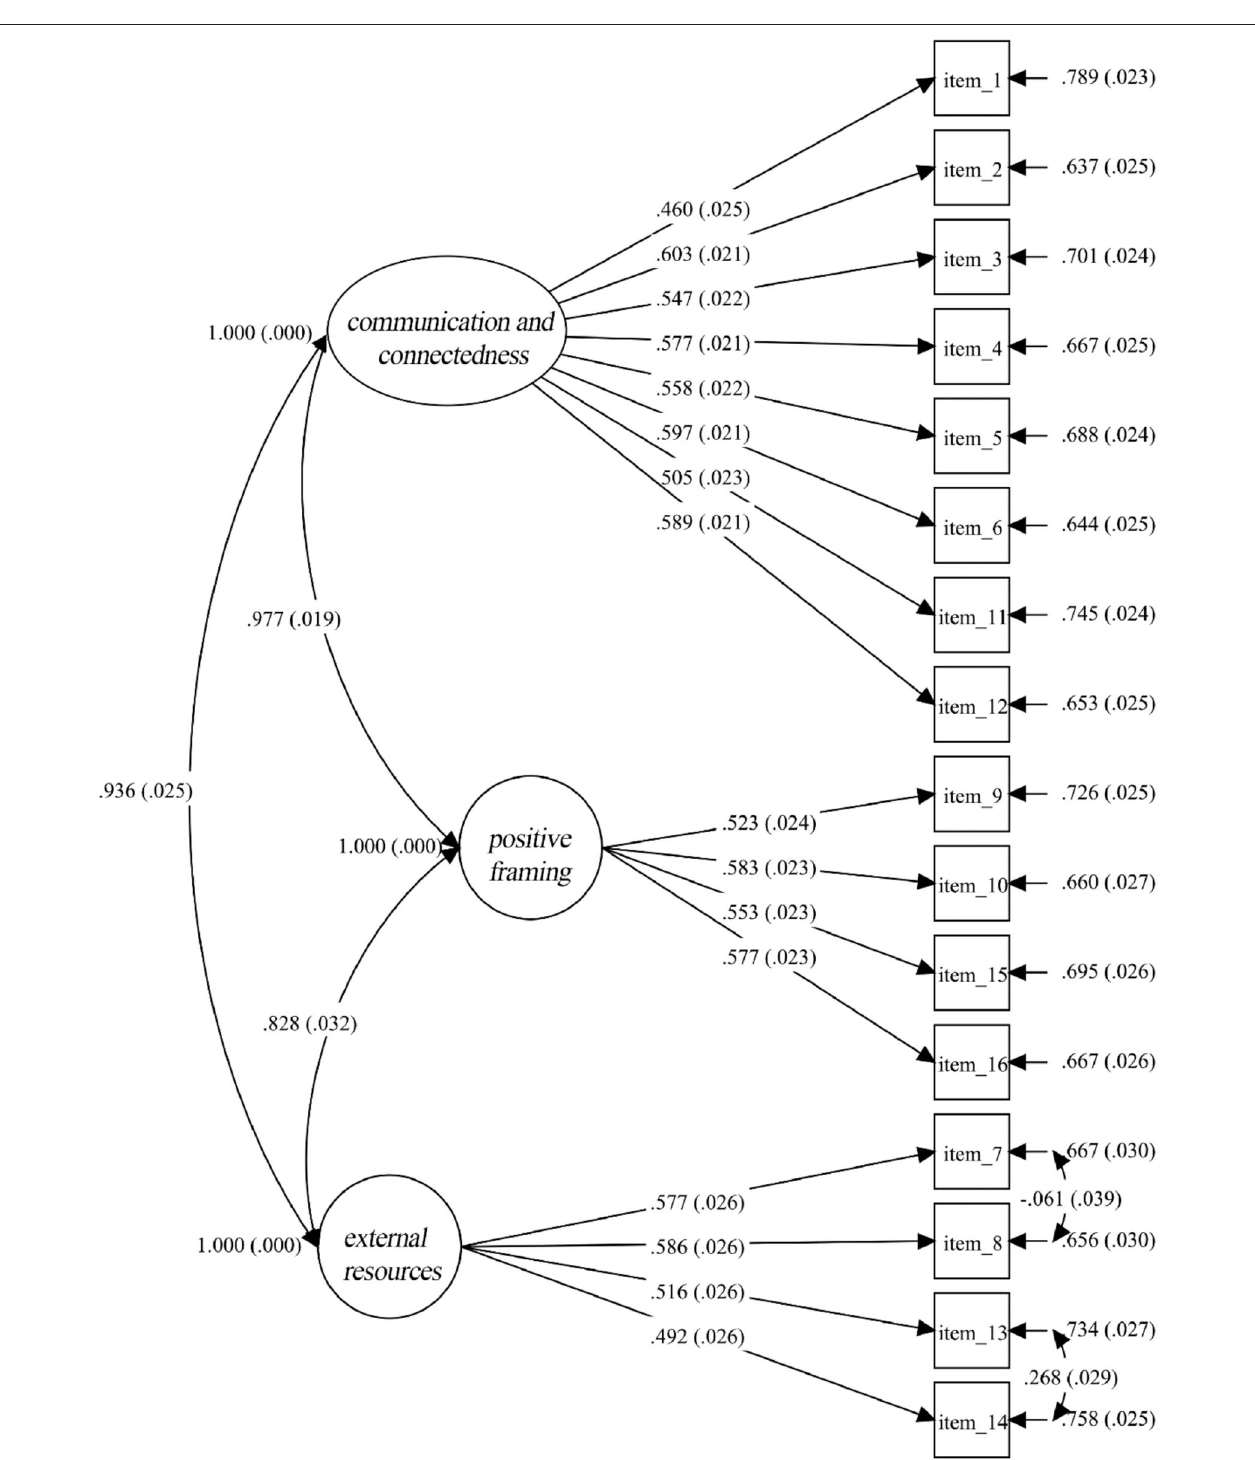
FIGURE 1 | Factor structure and standardized factor loadings of FRS16.